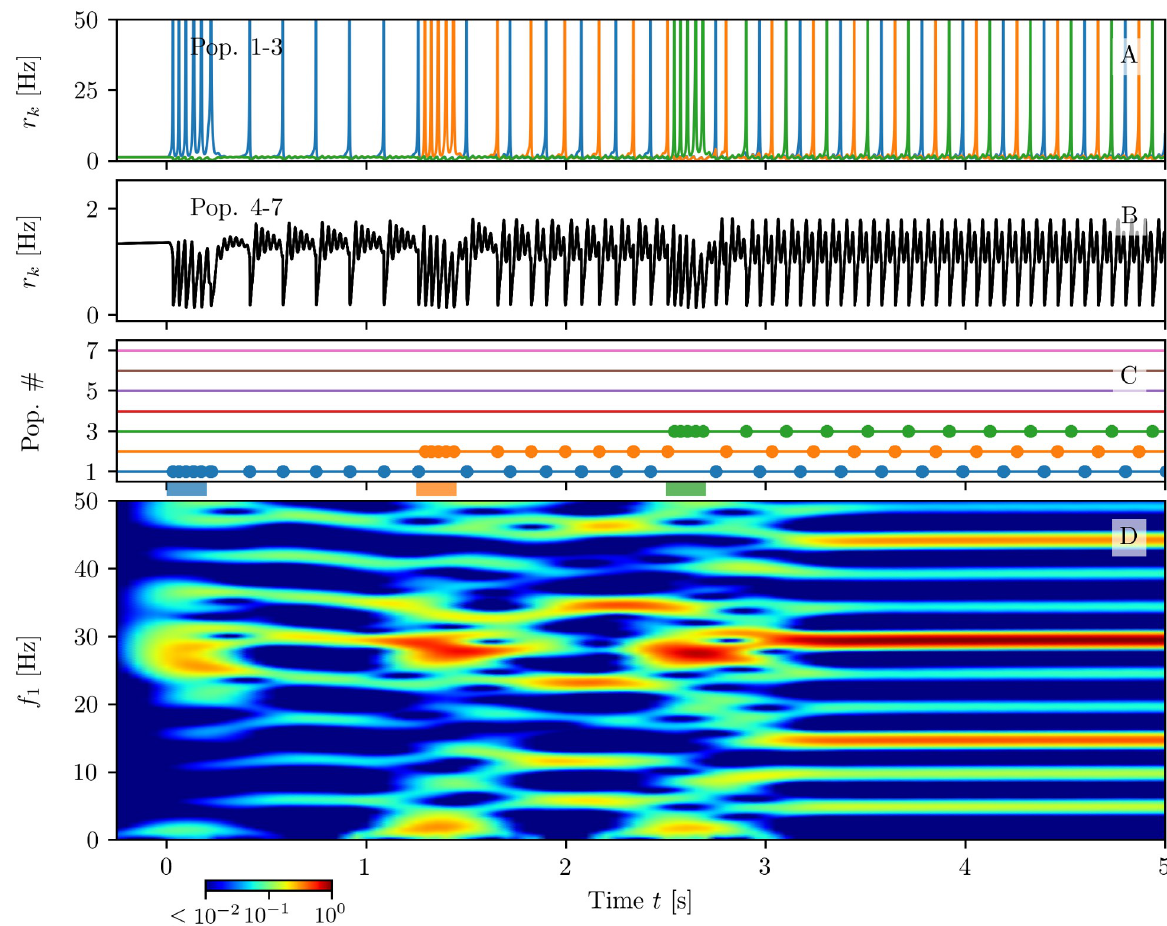
Fig 8. Multi-item memory loading. Firing rates r k ( t ) of excitatory populations: blue, orange and green curves corresponds to k = 1, 2, 3 ( A ), while the black curve refers to k = 4, ... , 7 ( B ). PBs of excitatory populations are shown in ( C ): horizontal lines in absence of dots indicate low activity regimes; coloured dots mark the PBs’ occurrences. The coloured bars on the time axis denote the presence of a stimulation pulse targeting the corresponding population. Only populations k = 1, ... , 3 are stimulated in the present example. The spectrogram of the average membrane potential of population one v 1 ( t ) is reported in panel ( D ). Parameters: N pop = 7, t e